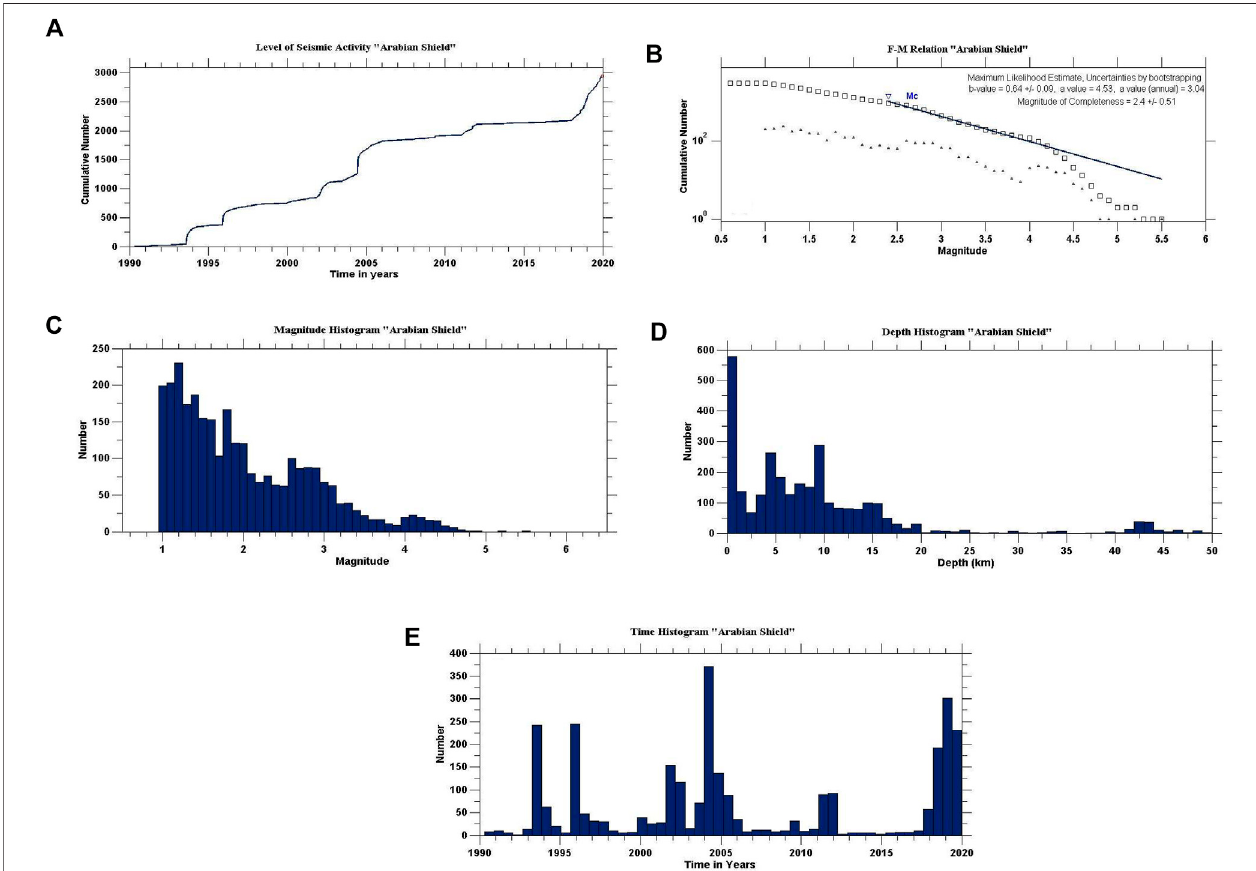
FIGURE 6 | The statistical analysis results of the Arabian Shield region using the whole dataset. (A) The evolutions among the levels of seismic activities, (B) the magnitude – frequency relationship, Mc is the cutoff magnitude (triangles and squares show earthquake numbers and the cumulative earthquakes for each magnitude value, respectively), (C) the magnitude histogram, (D) the depth distributions, and (E) the time histogram.